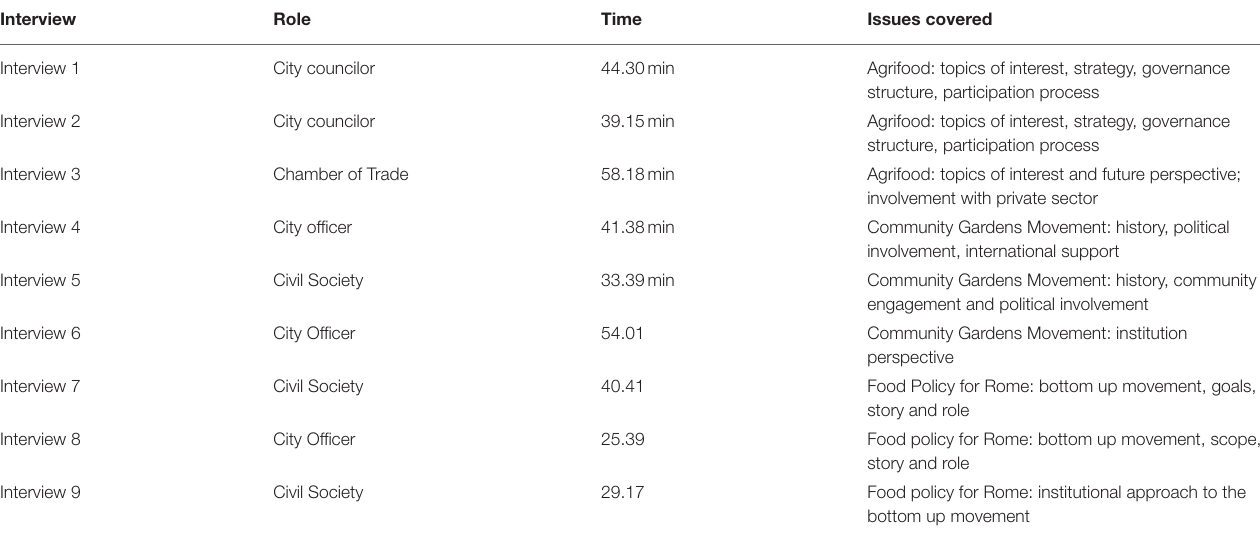
TABLE 3 | List of interviews and issues covered (source: